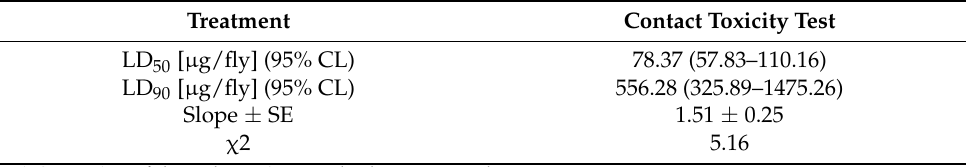
Table 3. Lethal dose (LD 50 and LD 90 ) of Piper nigrum L. essential oil against Stomoxys calcitrans according to contact toxicity testing 24 h after